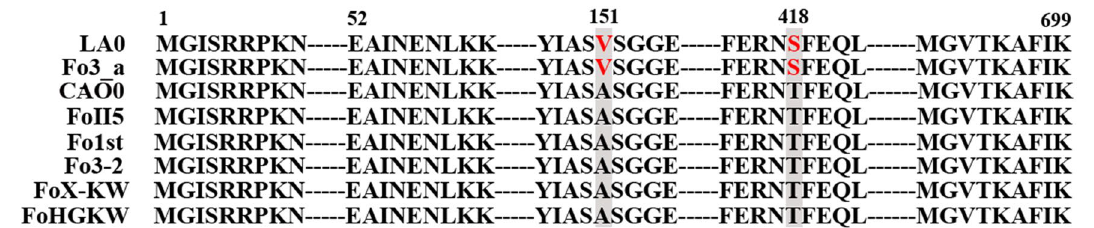
Figure 1. Alignment analysis of the amino acid sequences of FoMyo5 motor domains from Fo sensitive isolates Fo3_a, LA0 and natural low resistant isolates Fo3-2, FoII5, Fo1st, CAO0, FoX-KW and FoHGKW to phenamacril. The vertical boxes indicate the amino acid changes at the codon 151 and 418 that are responsible for phenamacril resistance.